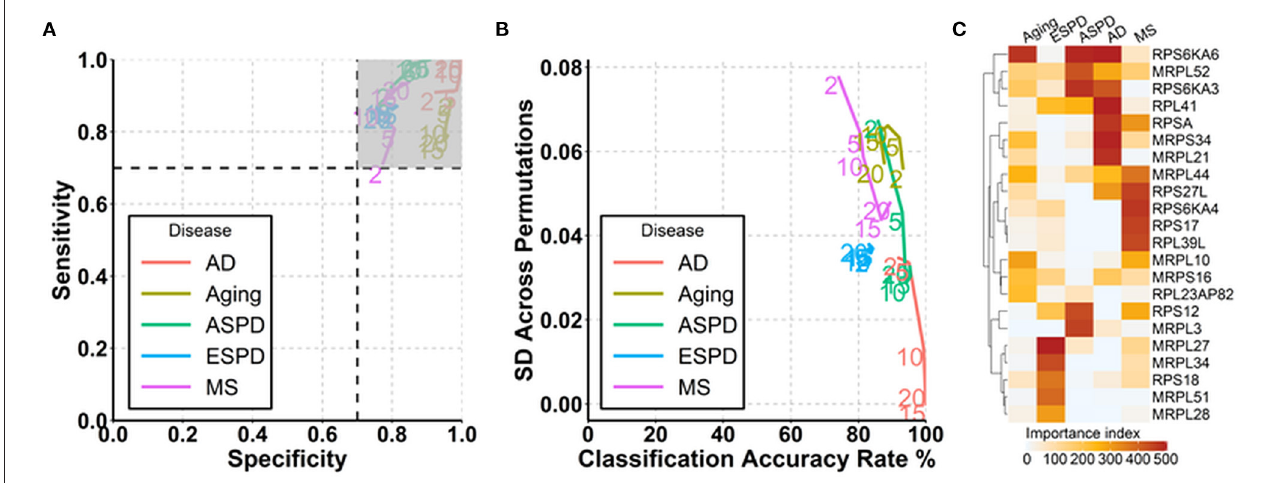
FIGURE 5 | Prediction of aging and age-related diseases using autoantibodies against ribosomal proteins. (A) Path plot of sensitivity and specificity for models includes the 2 to 20 top selected autoantibodies against ribosomal proteins for aging and neurodegenerative diseases. (B) Path plot of the accuracy rate of classification and its SD across 500 permutations for models includes the top 2 to 20 selected autoantibodies against ribosomal proteins for aging and neurodegenerative diseases. (C) Heatmap of importance index of top 5 selected autoantibodies against ribosomal proteins in aging and neurodegenerative